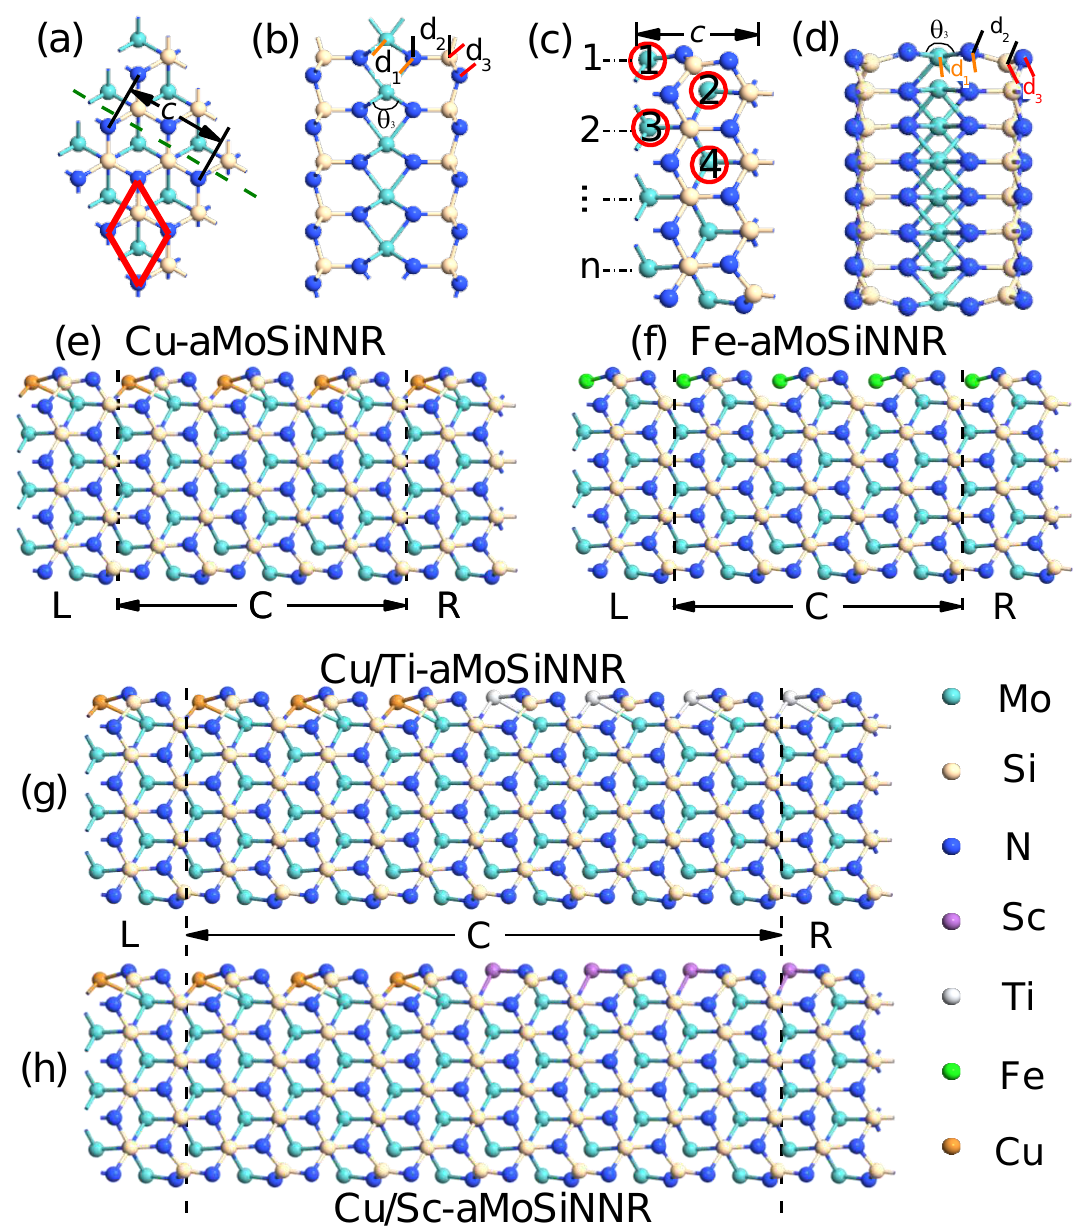
Figure 1. ( a ) Top and ( b ) side views of a 3 × 3 MoSiN supercell. The red rhombus shows a primitive cell, and the olive dashed line indicates the cutting direction for the armchair nanoribbon. ( c ) Top and ( d ) side views of a primitive cell of aMoSiNNR with the width number n = 4. The four red circled numbers 1–4 indicate the 4 doping positions discussed. Four typical two-probe devices made of edge-doped aMoSiNNRs, the ( e ) Cu- and ( f ) Fe-doped nanoribbons and the heterojunctions composed of ( g ) Cu/Ti- and ( h ) Cu/Sc-doped nanoribbons. The lattice constant c is the period along the ribbon direction for both the 2D and the 1D systems as shown in ( a ) and ( c ), respectively. The bond lengths d 1 , d 2 , and d 3 plus the angle θ 3 for a specific Mo atom in the 2D and 1D systems are marked in ( b ) and ( d ), respectively. Each two-probe system in ( e – h ) is partitioned into the left (L) and right (R) electrodes and the central (C) device region. Different atoms are represented by spheres of their own colors as illustrated.